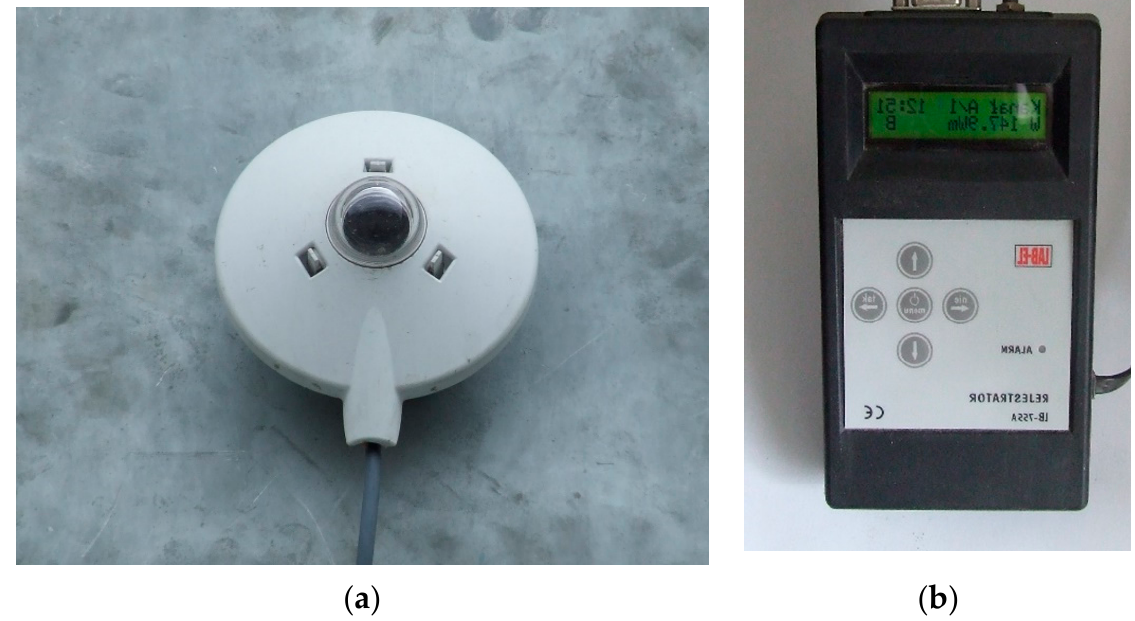
Figure 7. Measuring devices: ( a ) pyranometer for measuring the solar irradiance; ( b ) data recorder.